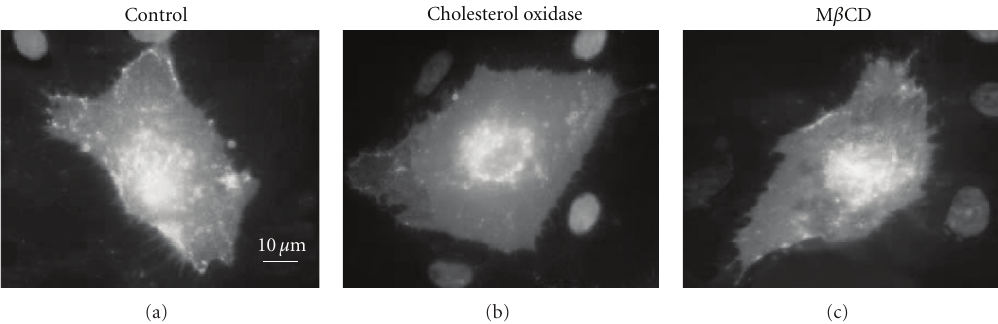
Figure 3: Visualizing noncaveolae lipid rafts by proximal imaging of GPI-anchored tt-GFP. Human umbilical vein endothelial cells are transfected with GPI-anchored temperature-tolerant green fluorescent protein (ttGFP) probe and exposed either to cholesterol oxidase (chol ox, 0.5U/l) for 60 minutes or 2 mM methyl- β -cyclodextrin (M β CD) for 30 minutes. Adapted from